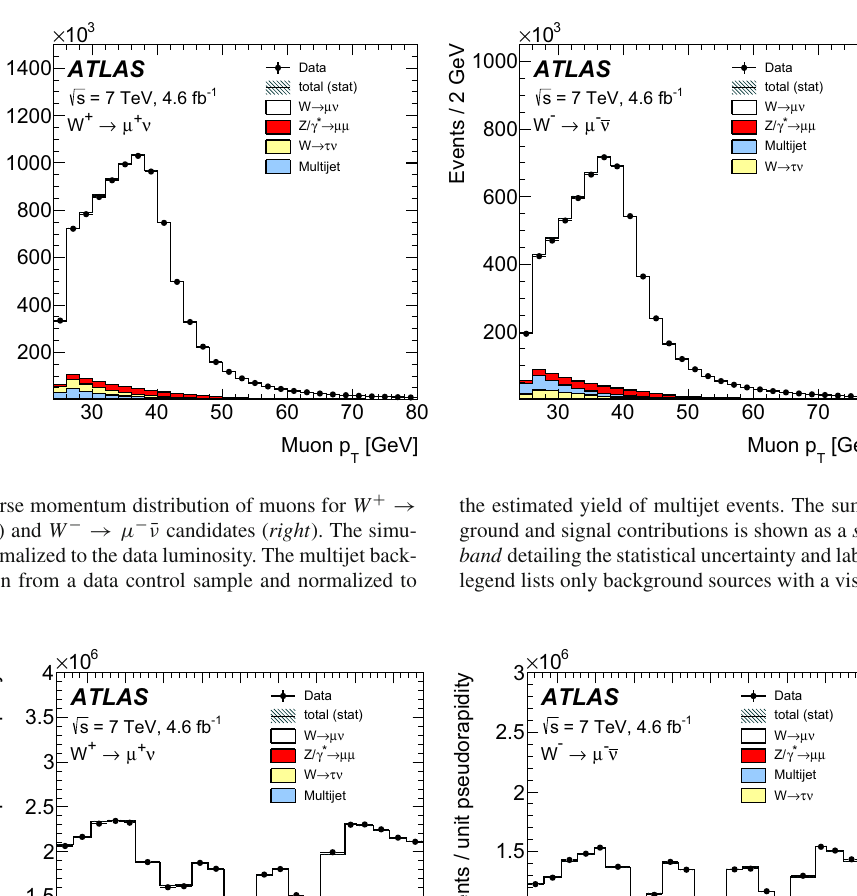
mated yield of multijet events. The sum of all expected background and signal contributions is shown as a solid line with a hashed band detail- ing the statistical uncertainty and labelled “total (stat)”. The legend lists only background sources with a visible